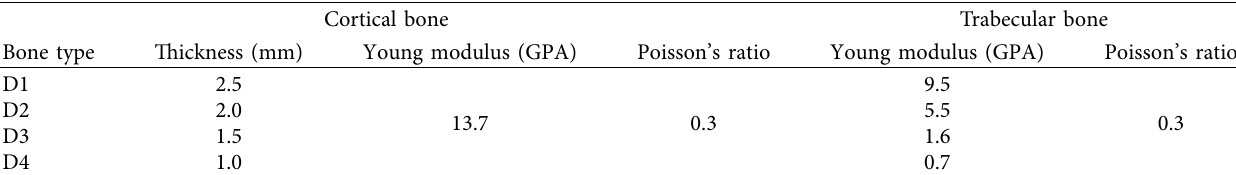
Table 3: General properties of the bones